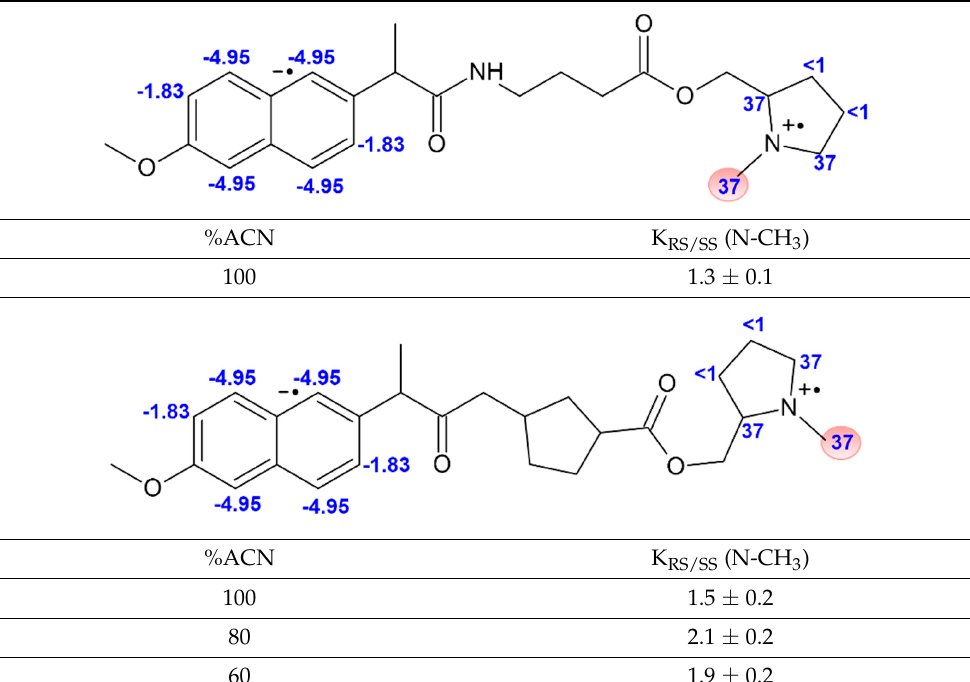
Table 1. Spin selectivity: RS/SS ratio of CIDNP coefficients ( K ) of protons (marked with red circles) for diastereomers of dyad I and corresponding HFI constants (G) in BZ (top) [15]; the same for dyad II (below, taken from [10]).